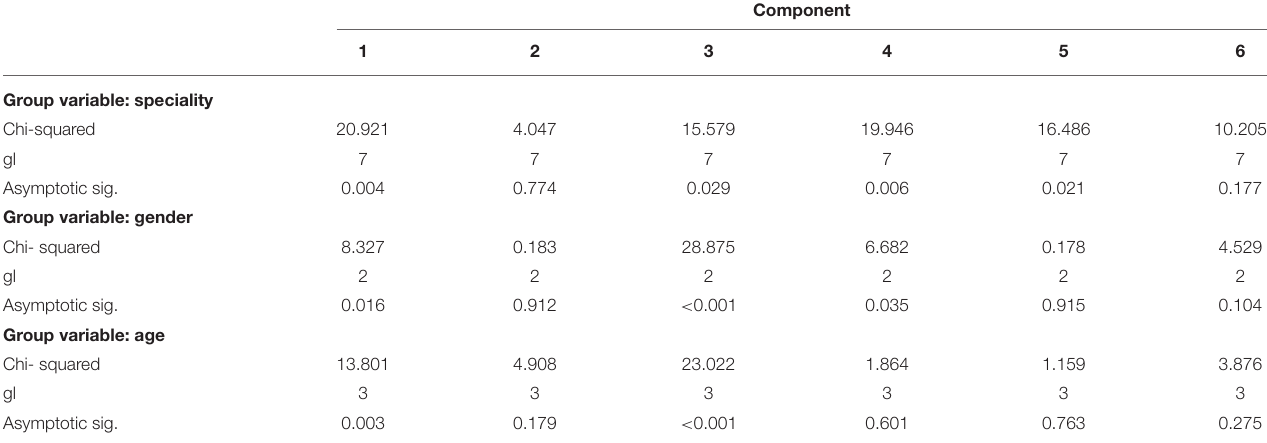
TABLE 2 | Kruskal-Wallis H -test statistics: variables of